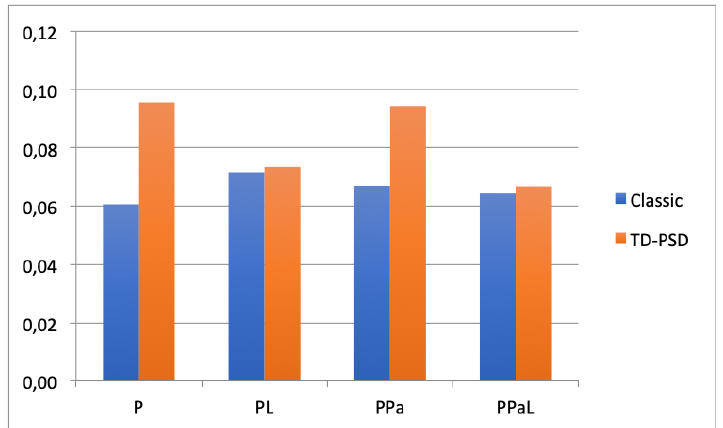
Figure 6. Inter-subject variability for different filters. Smaller values indicate greater consistency in performance across individual